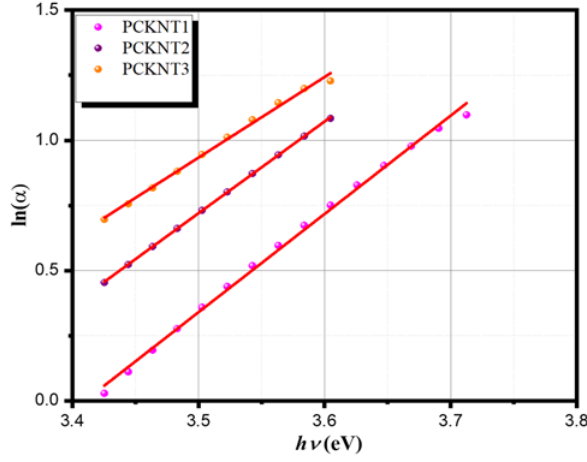
Figure 4. Plot of ln( α ) as a function of the photon energy (hv) of prepared